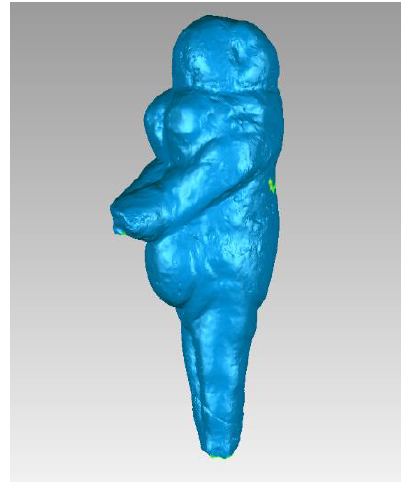
Figure 10. Final mesh model from the laser acquisition